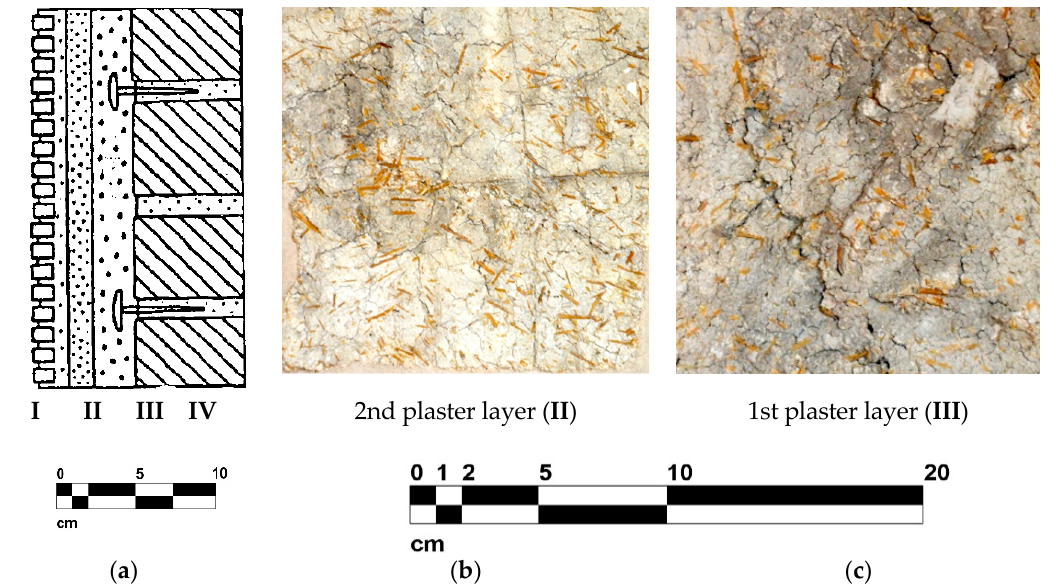
Figure 1. Structural layering of Byzantine wall mosaics: ( a ) section, IV—wall with protruding nails, III—1st plaster layer; II—2nd plaster layer; I—3rd plaster layer and tesserae, after [3]; ( b ) 2nd substrate layer, consisting of lime plaster, sand and straw and ( c ) 1st substrate layer, consisting of pure lime and straw (on display at the museum of Hosios Lukas, Greece).